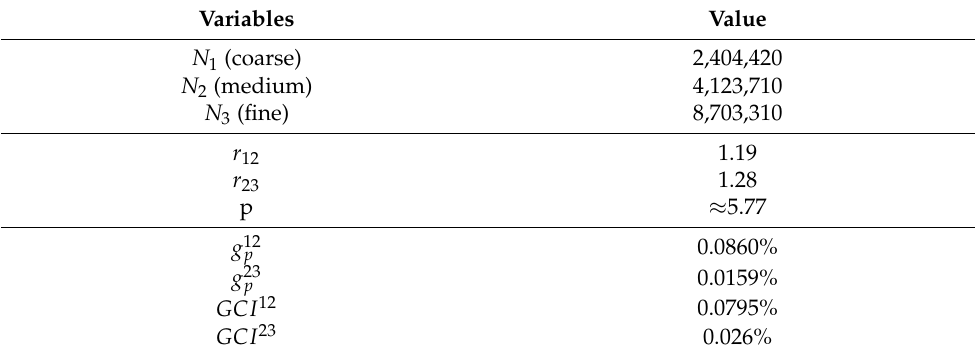
Figure 15. Verification of grid independence. Table 3. Calculation of the grid convergence index by Richardson extrapolation method.